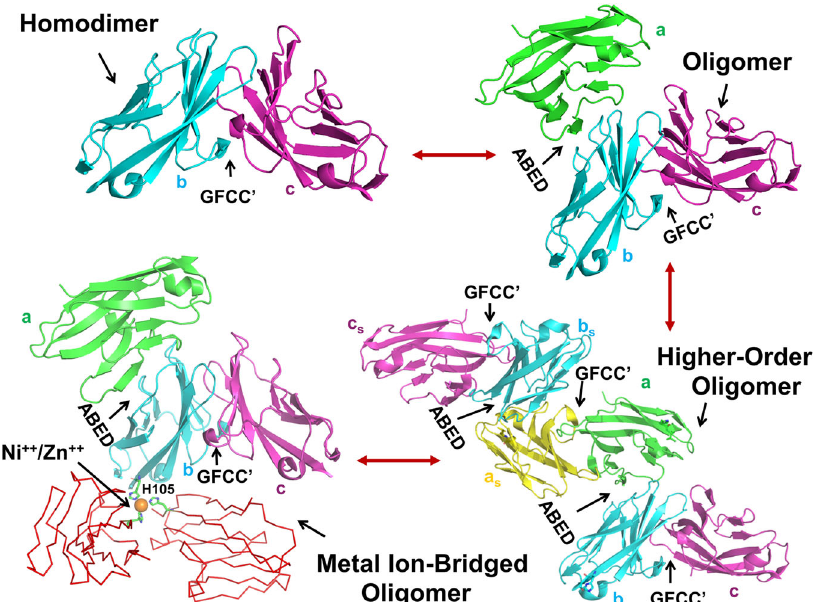
Fig. 8 Oligomerization model of human CEACAM1. Human CEACAM1 dimerization is mediated by primary GFCC ’ face which enables oligomerization through fl exible ABED face as observed in the hCEACAM1 oligomeric crystal structure for molecules a (green), b (cyan) and c (magenta). The GFCC ’ face is a central force of this oligomeric assembly as it not only governs human CEACAM1 monomer – dimer equilibrium and interactions with ligands, but also enables highly fl exible ABED-mediated interactions to form oligomers (wherein molecules b (cyan) and c (magenta) mediate GFCC ’ face interactions and molecules a (green) and b (cyan) mediate ABED face interactions) and higher-order oligomers (two hCEACAM1 oligomers as observed in the crystal structure, formed by molecules a, b and c and its symmetry mates labeled a s (yellow), b s (cyan) c s (magenta), wherein molecules a (green) and a s (yellow) mediate similar GFCC ’ face interactions observed for molecules b (cyan) and c (magenta)). Having fl exibility in GFCC ’ and ABED face enables hCEACAM1 molecules to further bridge to other CEACAM1 molecules (shown here by red ribbon representation) through metal ions (Ni ++ or Zn ++ , shown by orange sphere) via residues H105 as shown by green stick